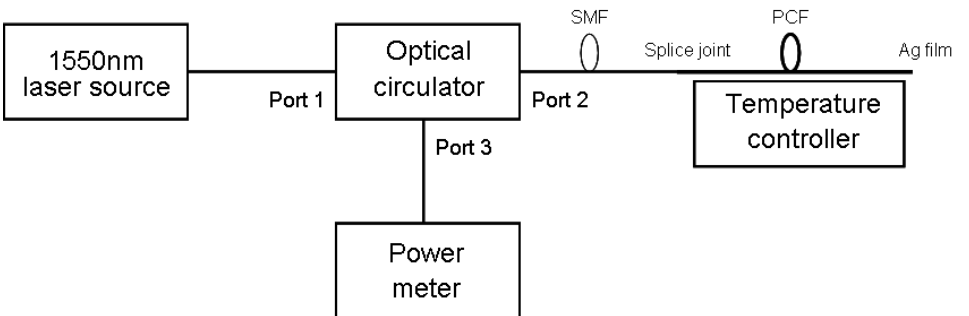
Figure 4. Scheme of the experimental setup for the LMA-8 PCF sensor probe.